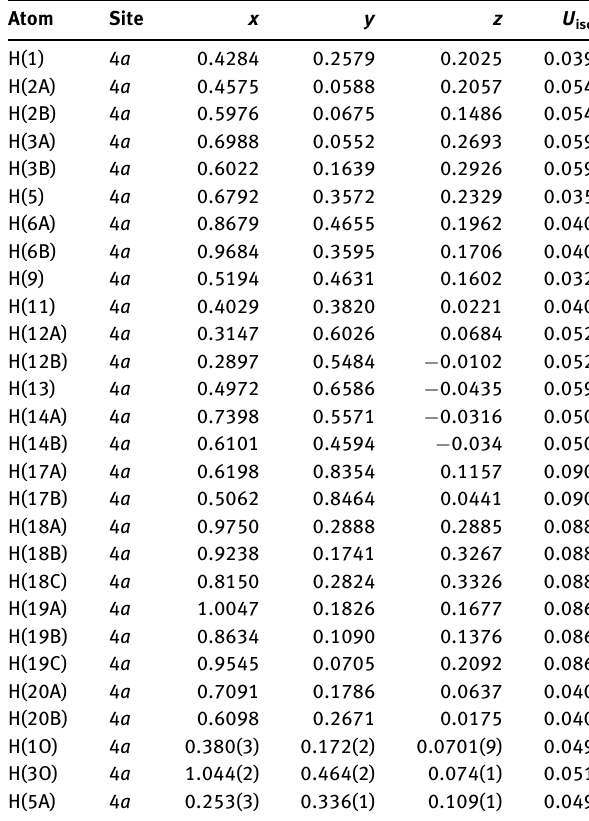
Table 2: Fractional atomic coordinates and isotropic or equivalent isotropic displacement parameters (Å 2